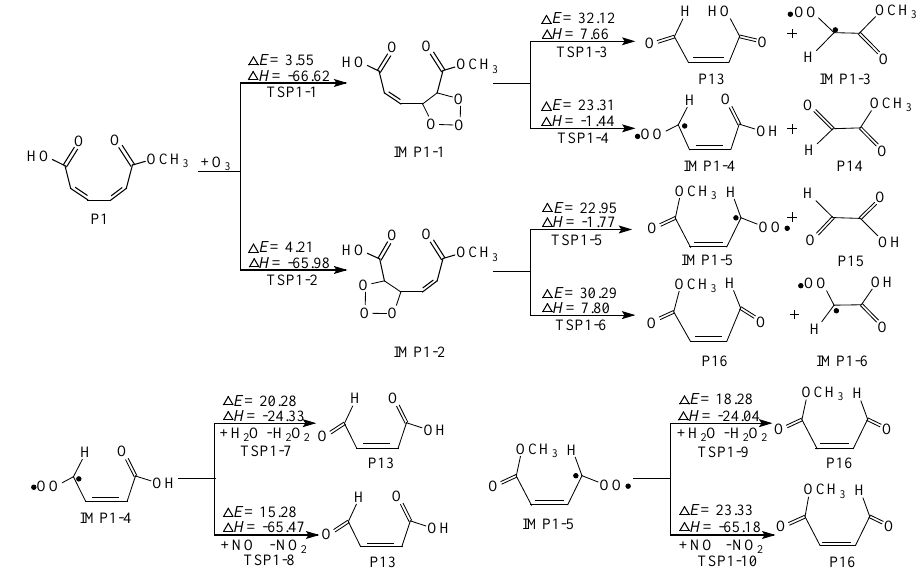
Figure 7. Further reaction of P1, ∆ E : potential-energy barriers, ∆ H : heats of reaction, TS: transition state, IM: intermediate, P: product.